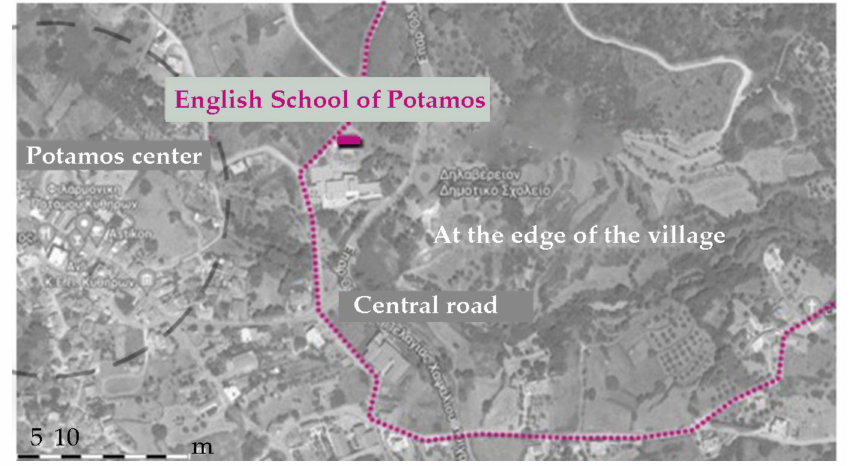
Figure 19. The Location of the English School of Potamos in Kythera, modified after